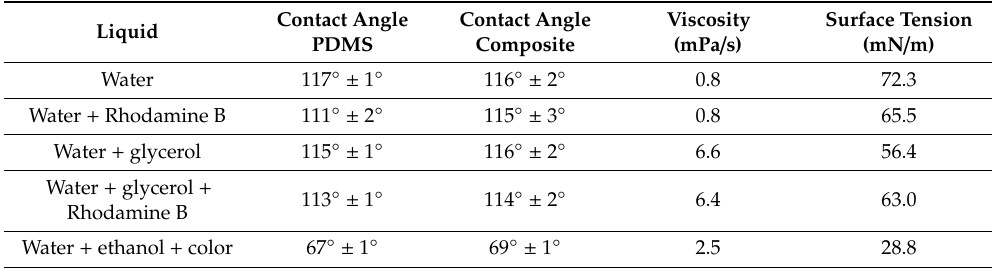
Table 2. Properties of liquids used in